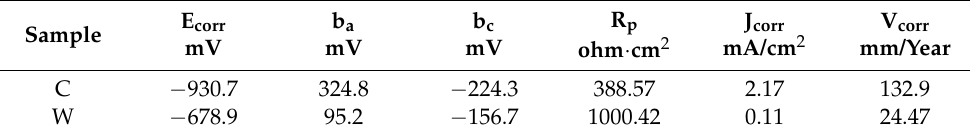
Figure 7. ( a ) Tafel and ( b ) cyclic diagrams for C and W samples. Table 4. Linear Tafel parameters for C and W samples.